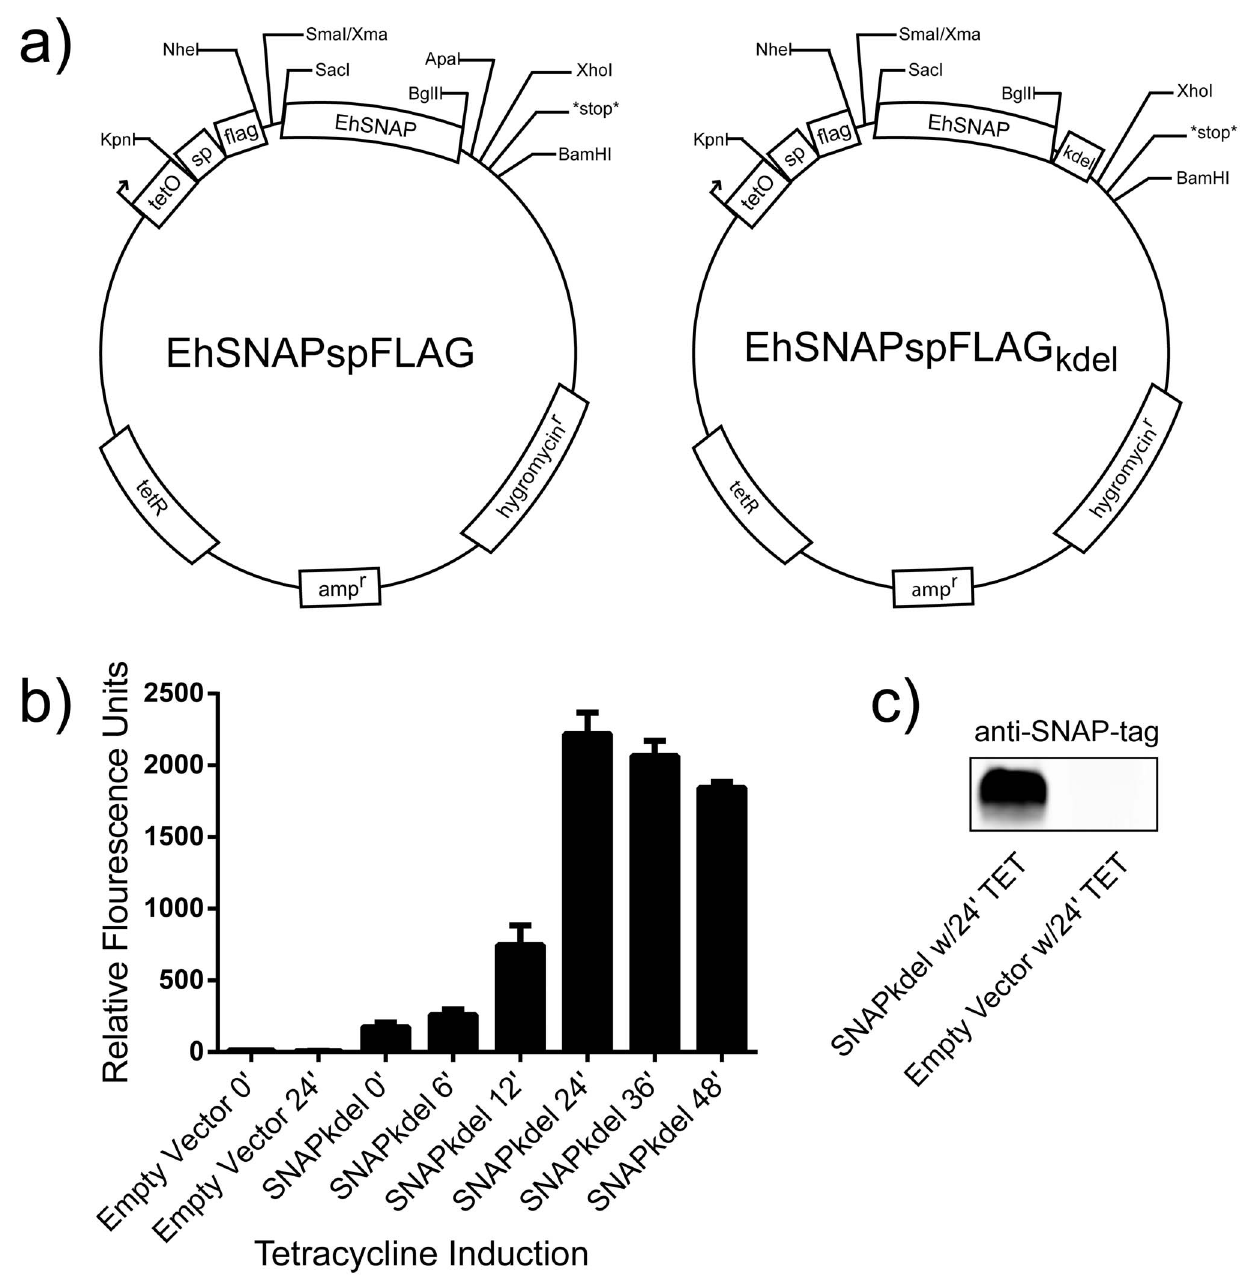
Figure 1. Tetracycline-regulated SNAP protein expression in E.histolytica . (A) Vector maps of EhSNAPspFLAG with and without the KDEL endoplasmic reticulum retention signal. (B) Time course of SNAP-tag protein expression induction using tetracycline, measured by flow cytometry. Times indicated in hours post addition of tetracycline. Values are mean and standard deviation for two experiments. (C) Western blot of trophozoite lysate from transfected cells induced with tetracycline for 24 hours. SNAP protein expression was measured to be approximately 76 times greater in trophozoites expressing SNAP-kdel compared to an empty vector control.